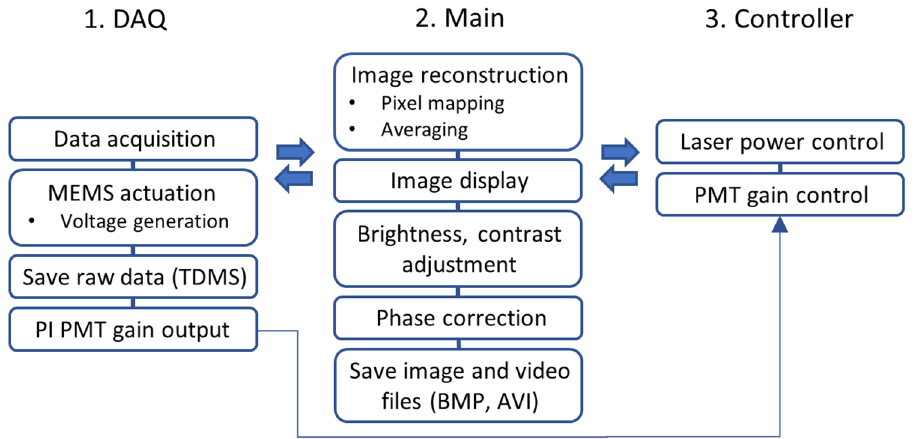
Figure 7. System software architecture. The user interface includes modules for (1) data acquisition (DAQ), (2) main panel, and (3) controller panel. The programs run simultaneously and communicate with each other via message queuing. Key – MEMS: microelectromechanical systems, TDMS: technical data management streaming, PI: proportional-integral, PMT: photomultiplier tube. Image and video files are saved in BMP and AVI format,